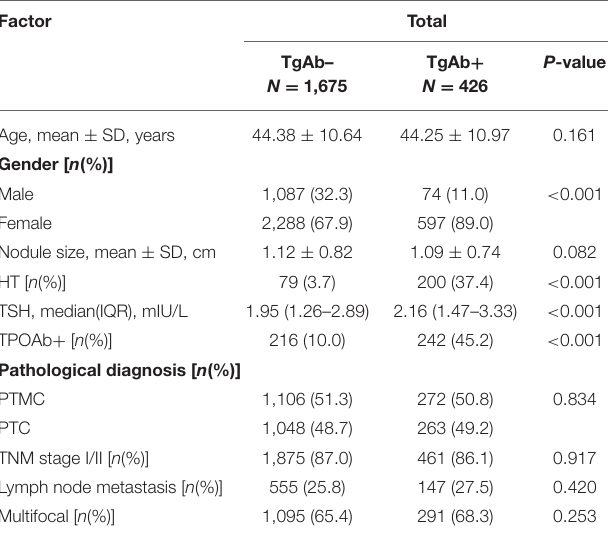
TABLE 4 | Logistic regression analysis to determine the association between tested factors and PTC.